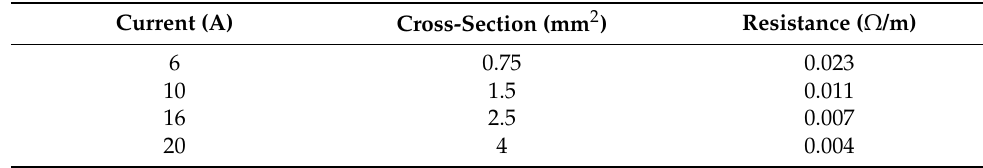
Table 1. Standardised cable cross-section area per maximum current according to IEC 60228 and the corresponding resistance per meter from (4), using the resistivity of copper (0.0171 Ω mm 2 /m). Current (A) Cross-Section (mm 2 ) Resistance ( Ω /m)